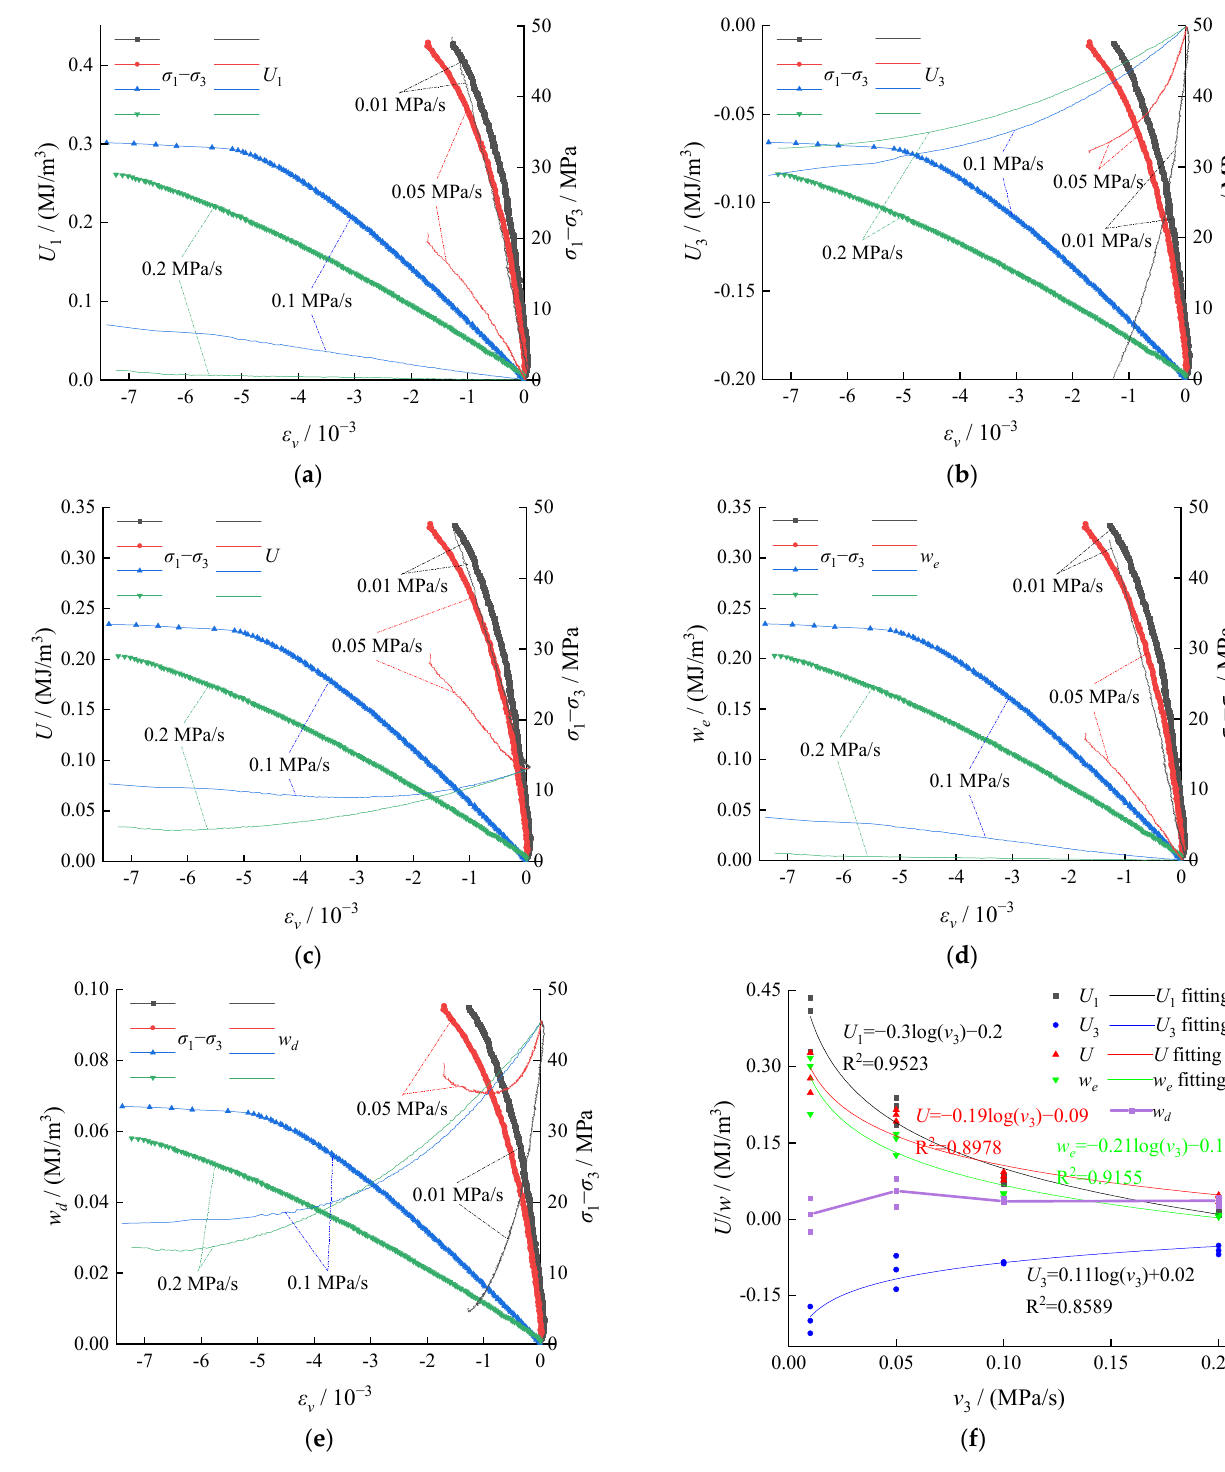
Figure 8. Energy evolution: ( a ) work of axial pressure, U 1 ; ( b ) work of confining pressure, U 3 ; ( c ) total work, U ; ( d ) elastic strain energy, w e ; ( e ) plastic strain energy, w d ; and ( f ) energy and unloading rate.